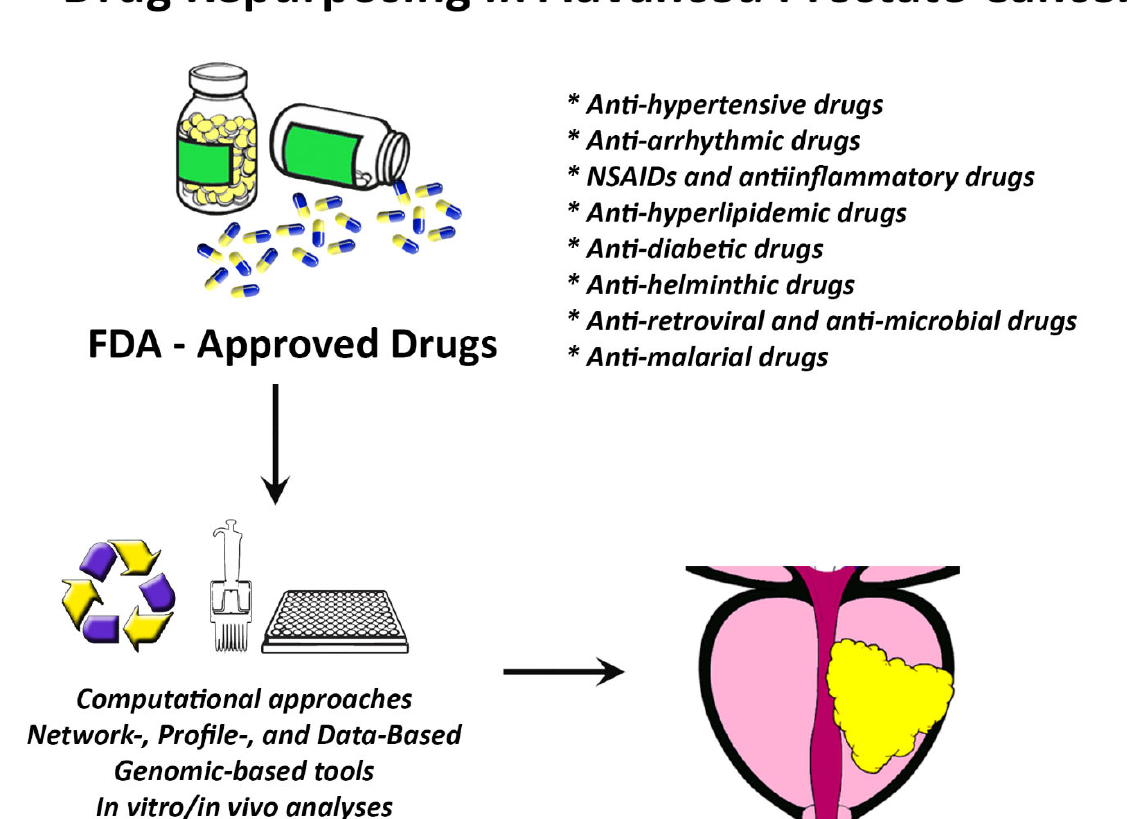
Figure 2. Drug repurposing in advanced prostate cancer. Using computational approaches and pre- clinical analyses, many Food and Drug Administration (FDA)-approved drugs could be identified and repurposed to treat patients with advanced prostate cancer. Abbreviations: FDA: U.S. Food and Drug Administration; NSAIDs: non-steroidal anti-inflammatory